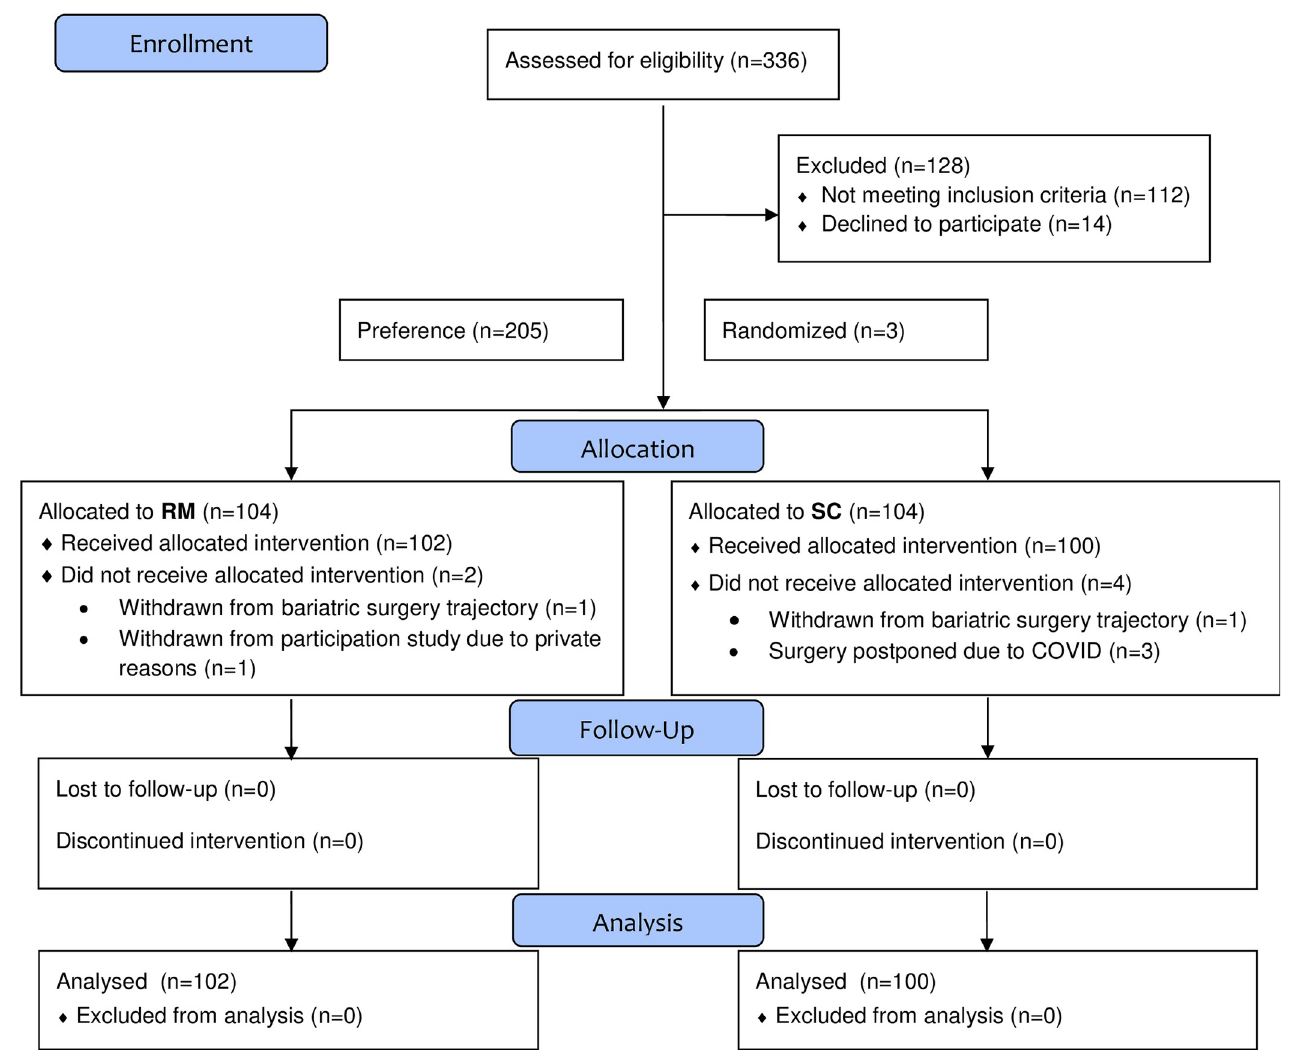
Fig 1. Enrollment, randomization, and follow-up (Consort 2010 Flow Diagram). RM = remote monitoring group. SC = standard care group.